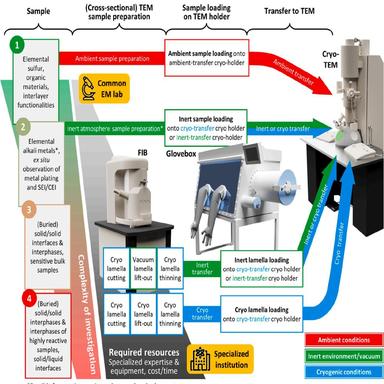
Overview of different workflows (1) to (4) for cryo-TEM including examples of observable materials/phenomena, sample preparation, sample loading, and sample transfer to the TEM. Investigations/workflows increase in complexity from top to bottom with strongly different infrastructural requirements (expertise, equipment). Studies of less reactive or nanoscaled (TEM-conformal) samples may be conducted in nanoanalytical laboratories (only cryo-TEM cooling holder required), increasingly complex analyses, requiri